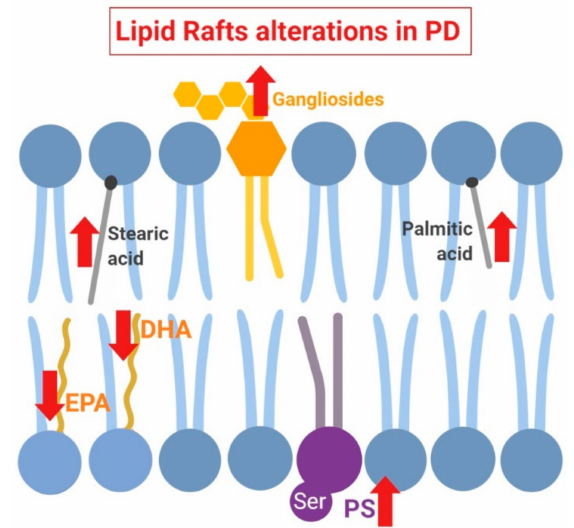
Figure 3. Schematic summary of lipid raft alterations in Parkinson’s Disease (PD). In this pathologic state, polyunsaturated docosahexaenoic acid (DHA) and eicosapentaenoic acid (EPA) are depleted, while levels of saturated fatty stearic and palmitic acids are increased. Furthermore, lipid raft content in gangliosides and phosphatidylserine (PS) is also pathologically